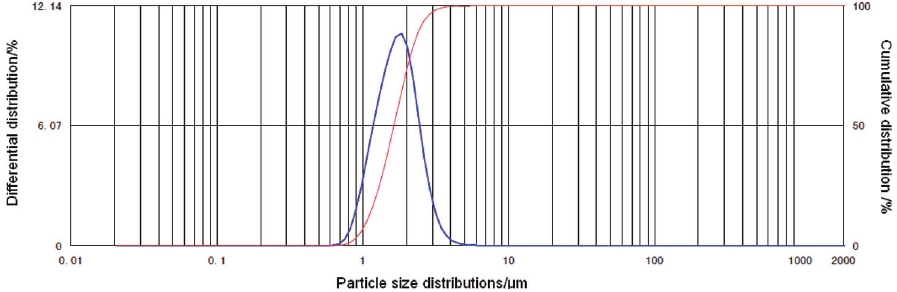
Figure 9: Particle size distributions of BaCO 3 powders prepared under optimal experimental conditions.